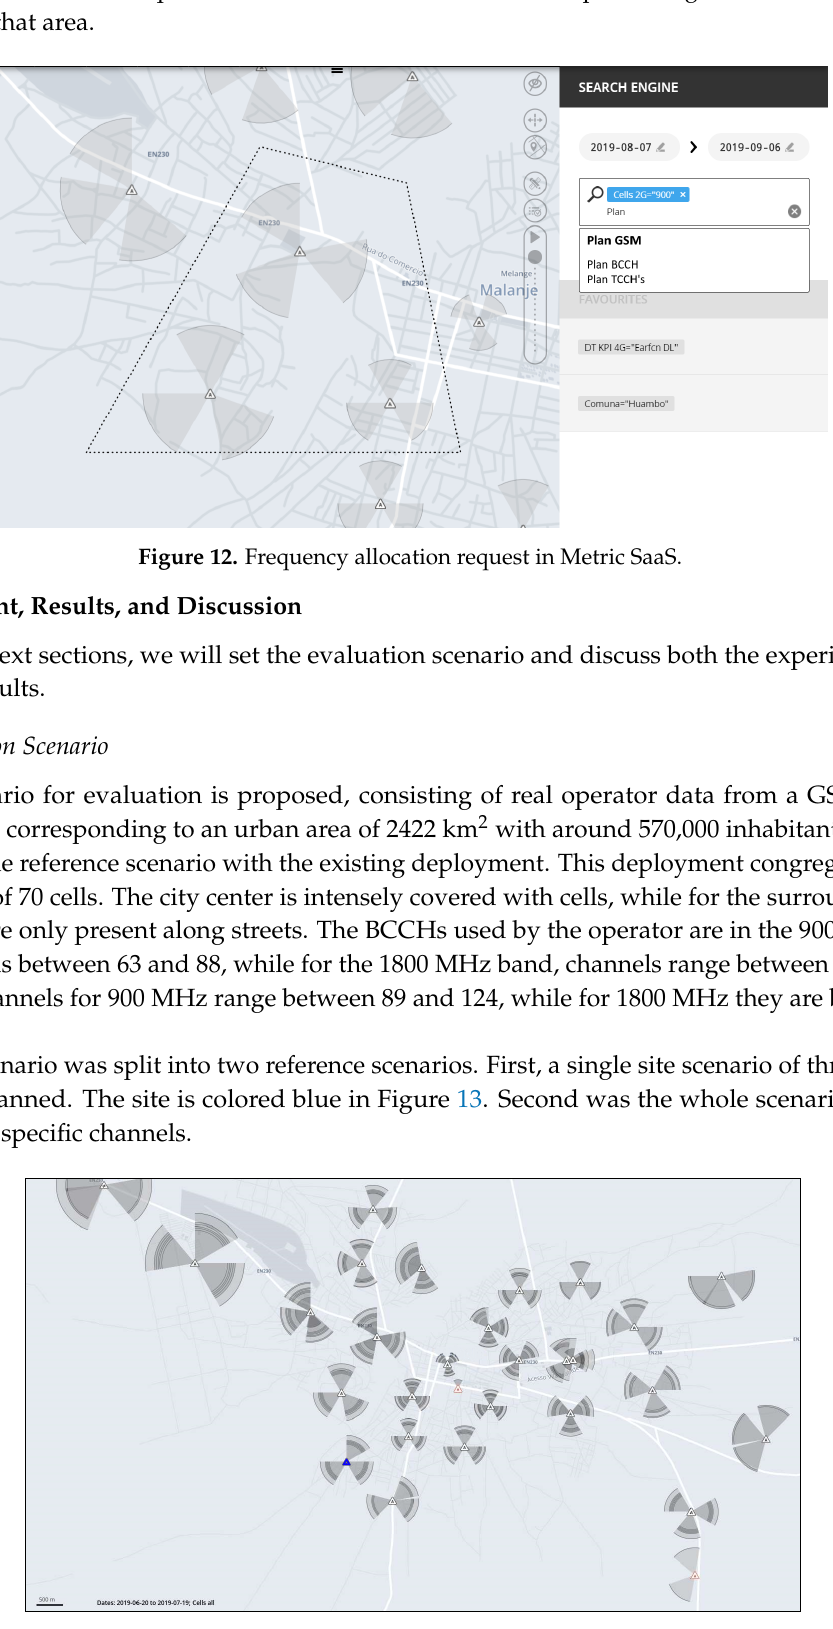
Figure 13. Evaluation scenario, extracted from a real Global System for Mobile communications protocol (GSM) cellular